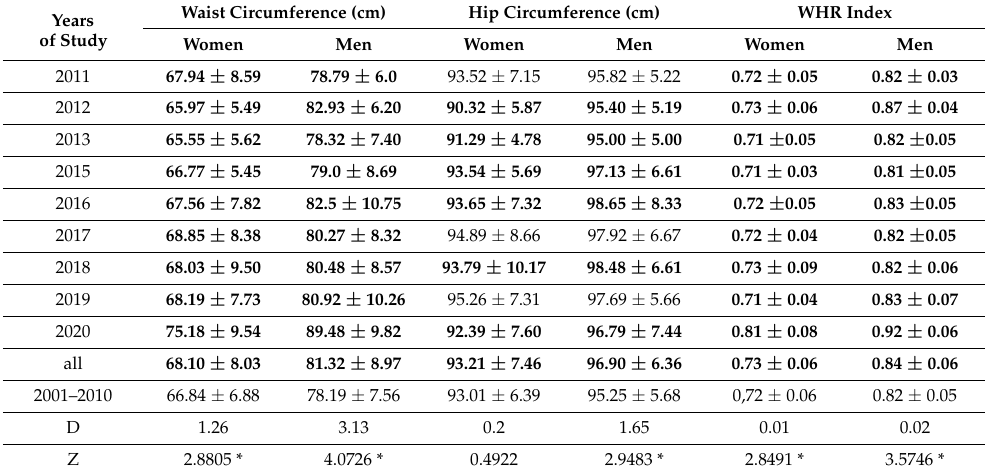
Table 3. Statistical characteristics (mean ± SD) of WHR index and waist and hip circumference.